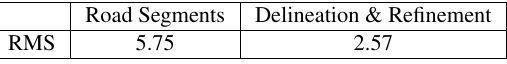
Table 1: RMS errors computed for our method’s result after road discrimination based on the Hough transform, and after delin- eation of the roads and refinement of their round